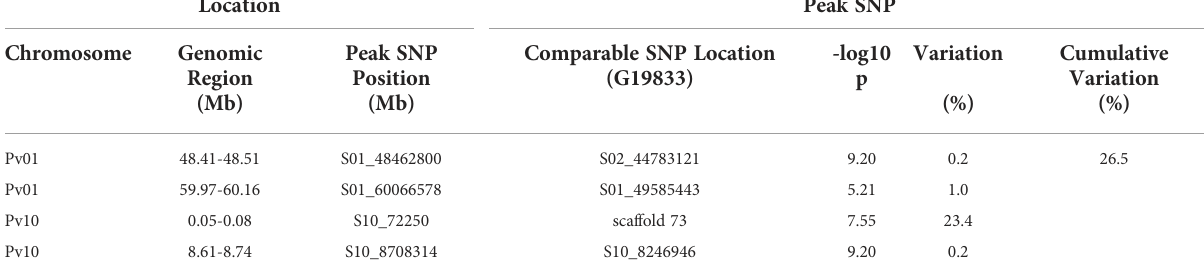
TABLE 3 Chromosome, base pair position, p-value, and variation of each of the four peak SNP using the UI111 v1.1